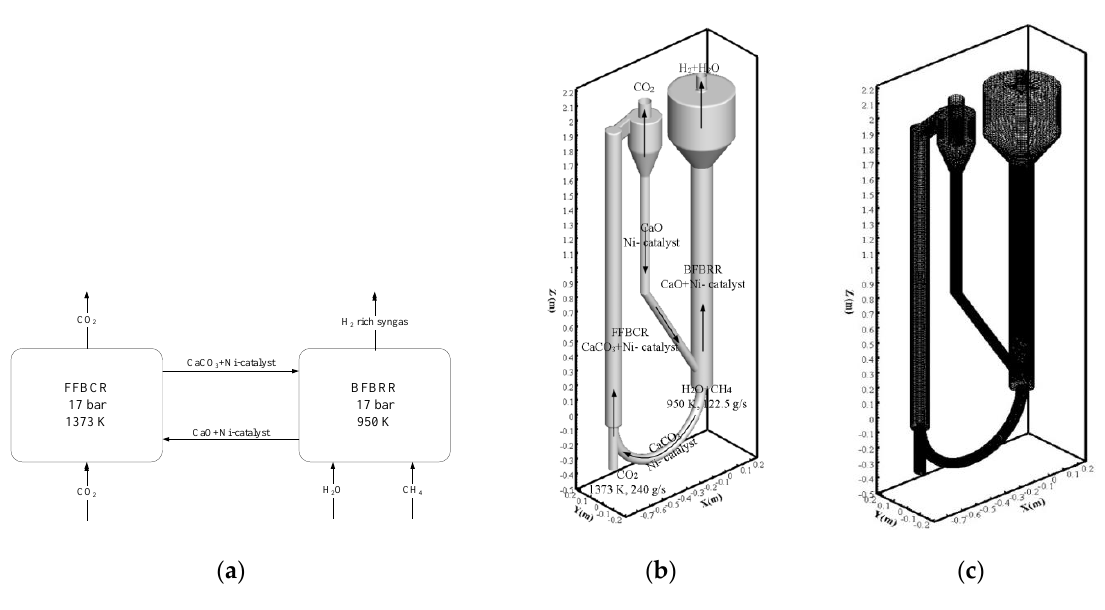
Figure 1. The dual fluidized bed reactor’s configuration. ( a ) Technical flow sheet of the dual fluidized bed reactor. ( b ) Structure of the dual fluidized bed reactor. ( c ) Mesh of the computational